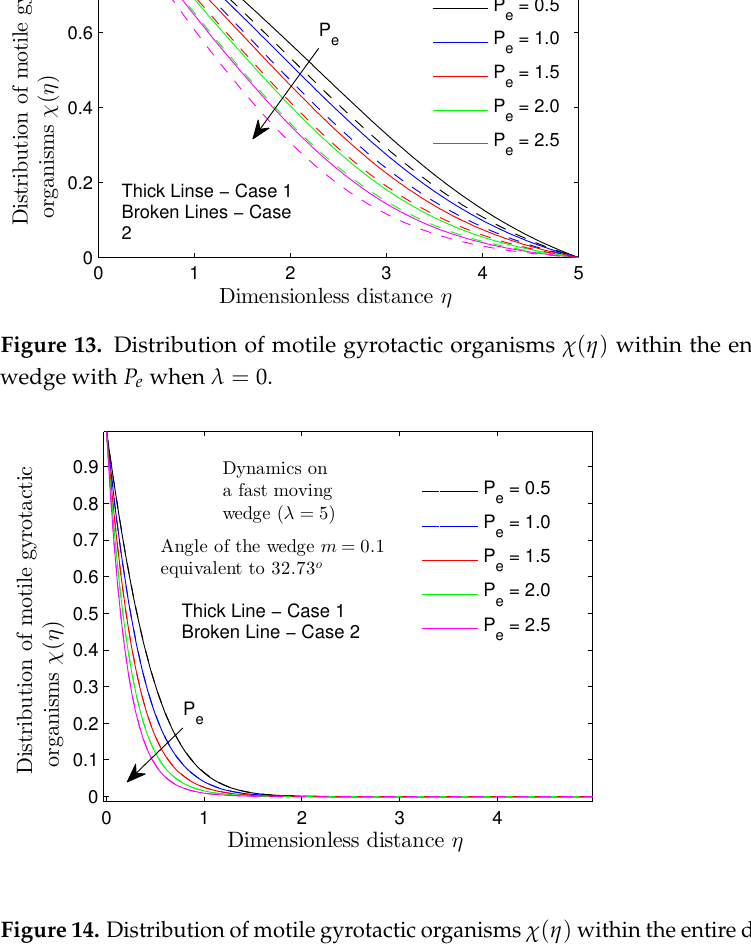
Figure 14. Distribution of motile gyrotactic organisms χ ( η ) within the entire domain on a fast-moving wedge with P e when λ =